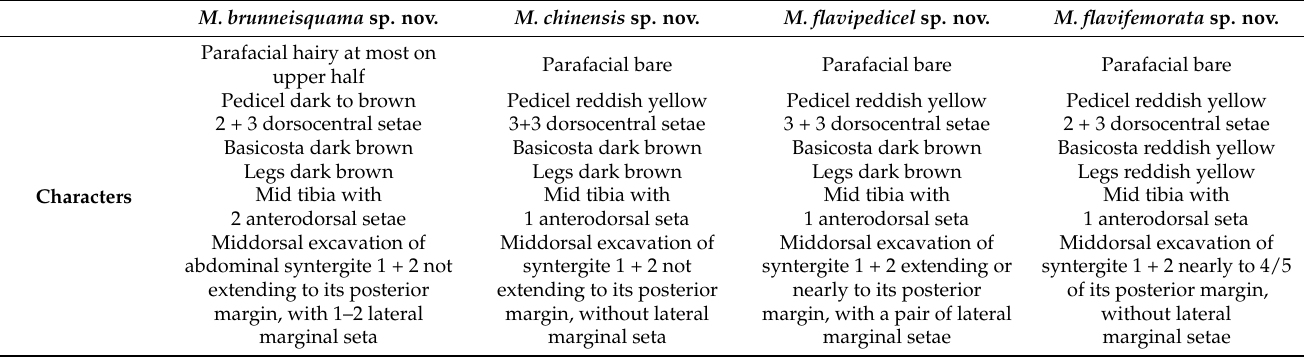
Table 1. Comparison of four new species of Macquartia